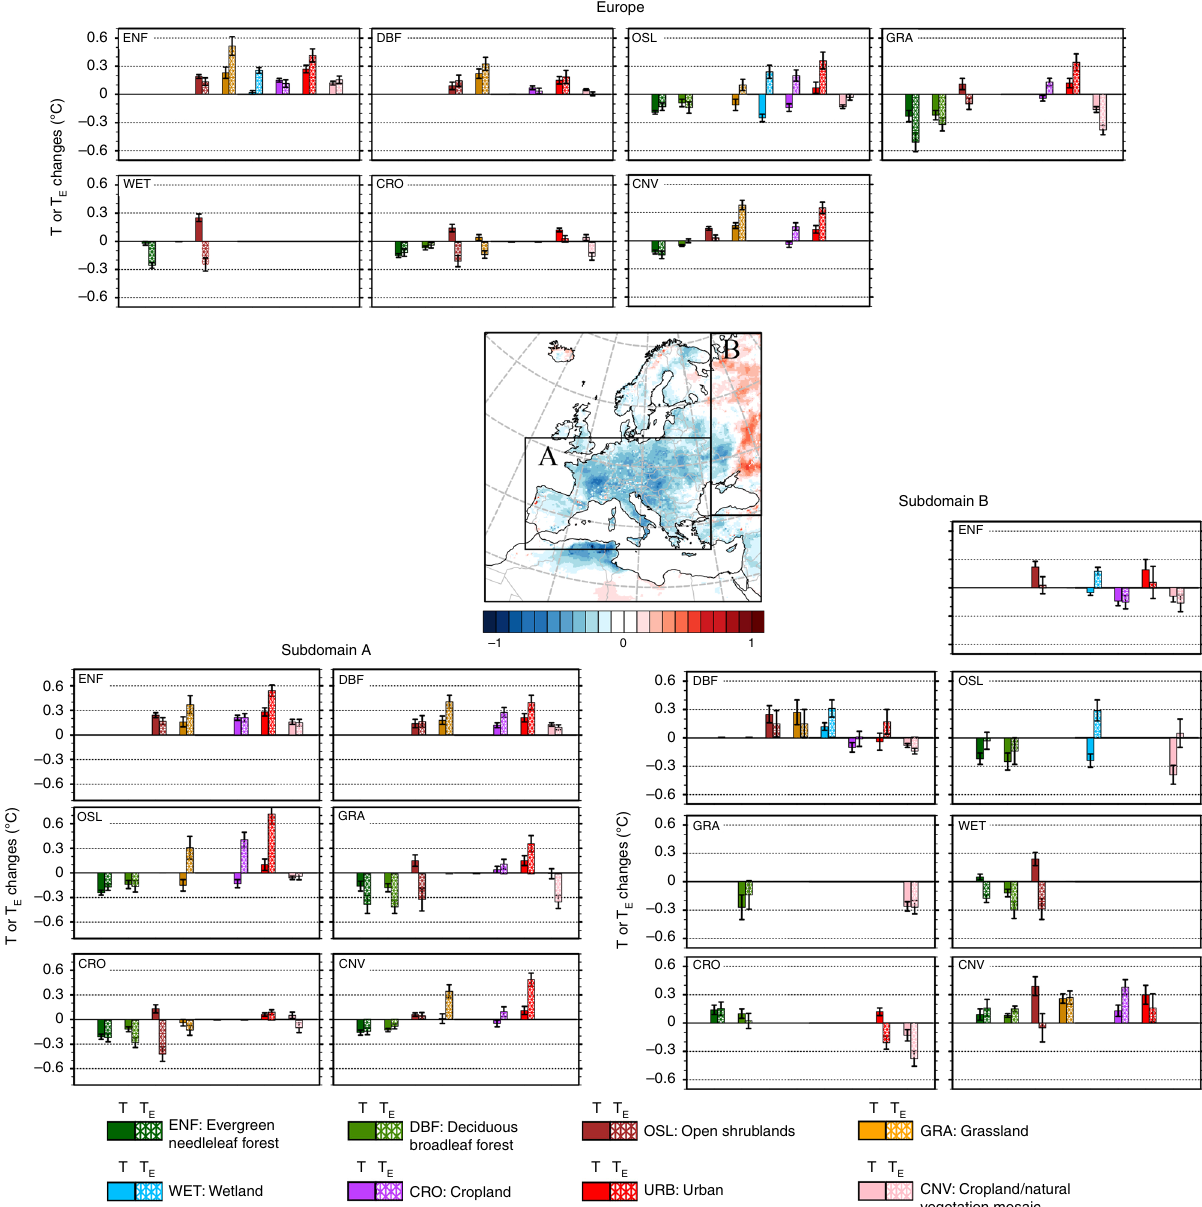
Fig. 6 Decomposition of the temperature changes to individual land cover changes. Temperature and equivalent temperature change signals are shown for the European domain and its major subdomains. In each subpanel, the transitions are to be read from the land class indicated in each top left corner to the different land cover classes indicated by the different colors in the horizontal axis. The full bar indicates changes in T , the bar fi lled with texture T E . The whisker indicates the standard error around the mean value. The map in the center shows the locations of the two subdomains and the color scale reproduces the annual mean temperature response (in °C) as in Fig.